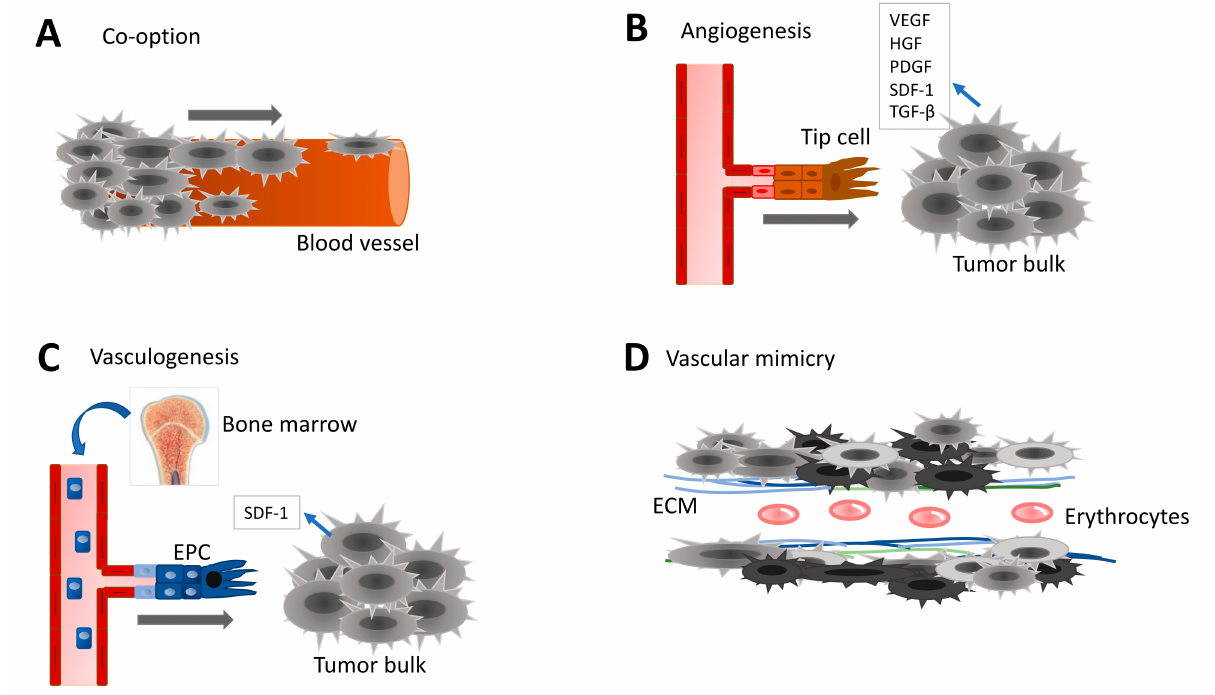
Figure 1. Different types of neovascularization occurring in GBM. ( A ) Vascular co-option of tumor cells migrating on existing blood vessels contributes to tumor spreading and invasion. Co-option requires direct binding between cancer cells and either endothelial cells (ECs), pericytes or extracellular matrix (ECM). ( B ) Angiogenesis corresponds to the creation of new blood vessels from pre-existing vascular network in order to increase oxygen and nutrient supply to the growing tumor mass. The ‘tip cell’ is attracted towards the tumor mass and takes the lead in the sprouting newly emerging vessel. Angiogenic factors include Vascular Endothelial Growth Factor (VEGF), Hepatocyte-derived Growth Factor (HGF), Platelet- Derived Growth Factor (PDGF), Stromal Derived Factor (SDF-1), and Transforming Growth Factor (TGF). ( C ) Endothelial progenitor cells (EPCs) originated from the bone marrow are circulating in the blood stream. Cancer cells recruit EPCs to participate in neovascularization. Often, the vasculogenesis is followed with angiogenesis. ( D ) Vascular mimicry aims at improving blood irrigation into the growing tumor mass. Cancer cells or cancer stem-like cells contribute to the formation of functional tubular-like structures. Capacity of cancer stem-like cells to transdifferentiate towards pericyte-like or EC-like is one of the key elements of vascular